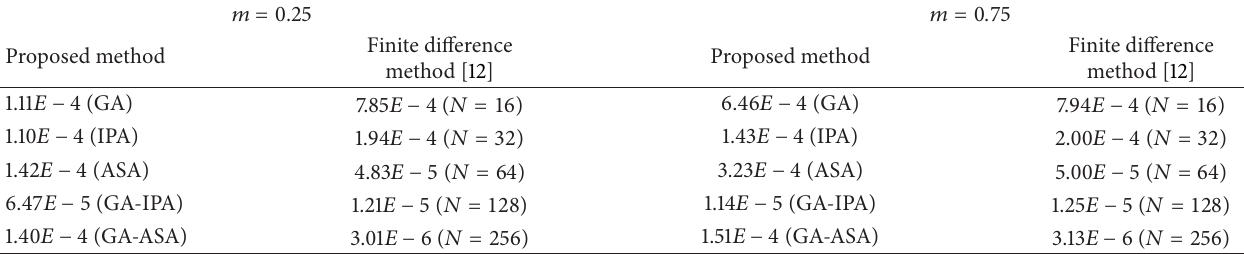
Table 13: Comparison of maximum absolute errors for Example 3 between the proposed method and the method given in [12]. 𝑚 = 0.25 𝑚 =